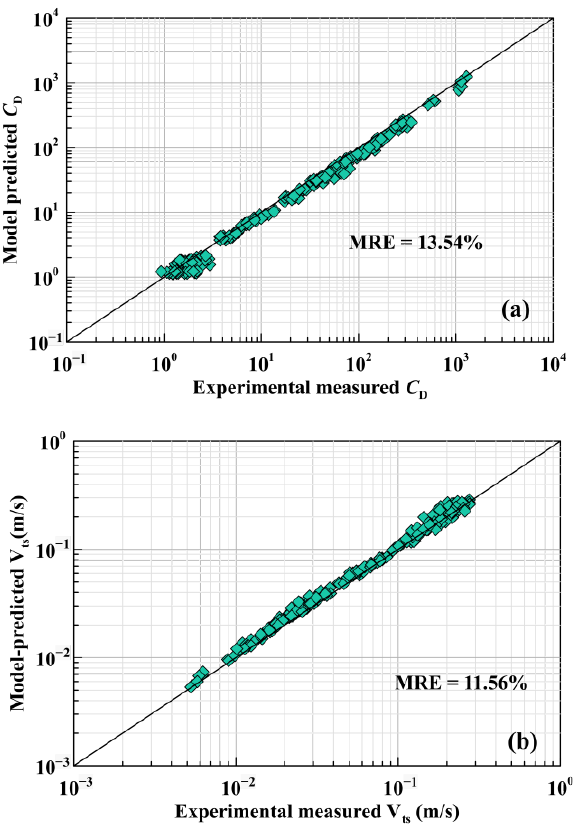
Figure 13. Comparison between the experimental measured and the predicted results of the proposed model for natural sands: ( a ) drag coefficient; ( b ) settling velocity.